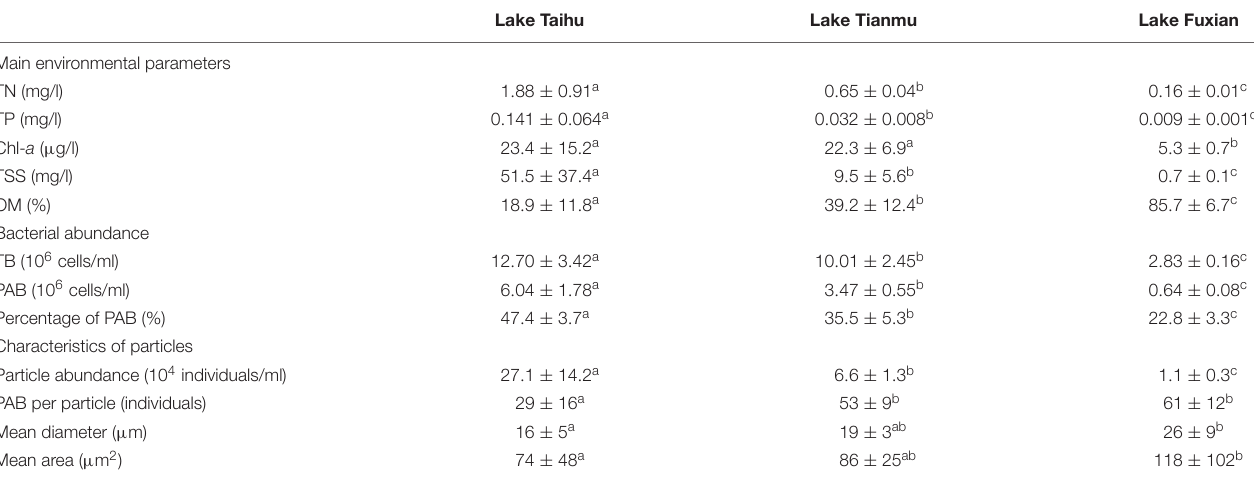
TABLE 1 | Mean values (mean ± SD) and comparisons among lakes (Kruskal–Wallis test) of main environmental parameters, bacterial abundance, and characteristics of particles in November 2019. Lake Taihu Lake Tianmu Lake